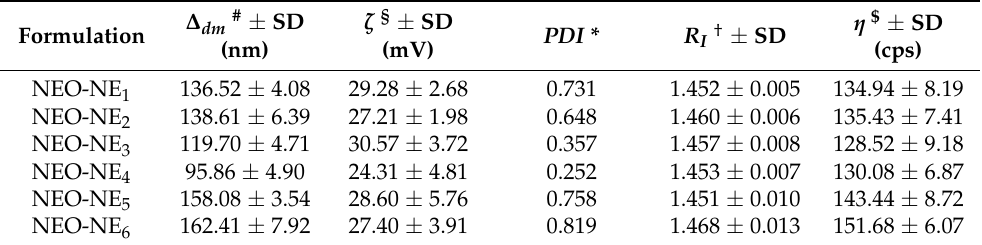
Table 3. Droplet diameter, surface charge, and rheological measures of selected NEO-NEs (mean ± SD, n = 3).